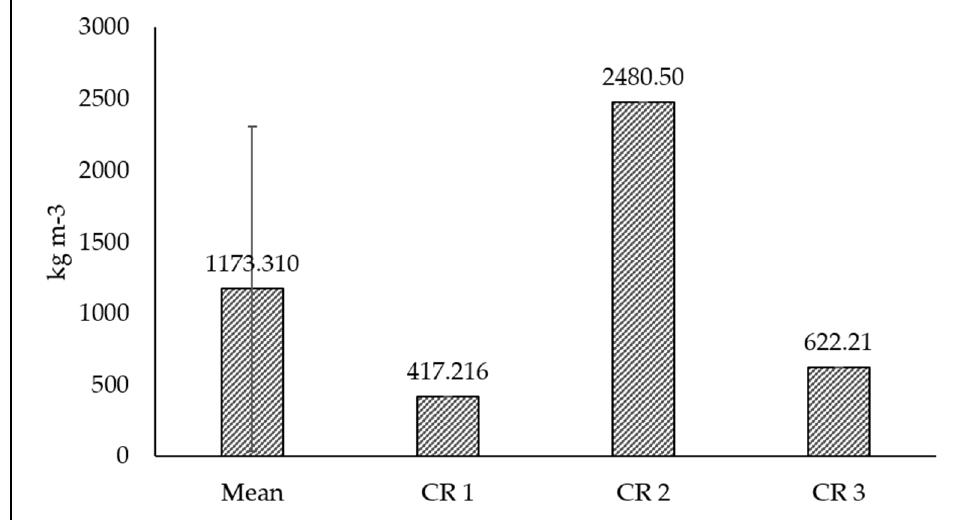
Figure 9. Total fish biomass in all three BK AR. Error bars indicate the standard deviation.